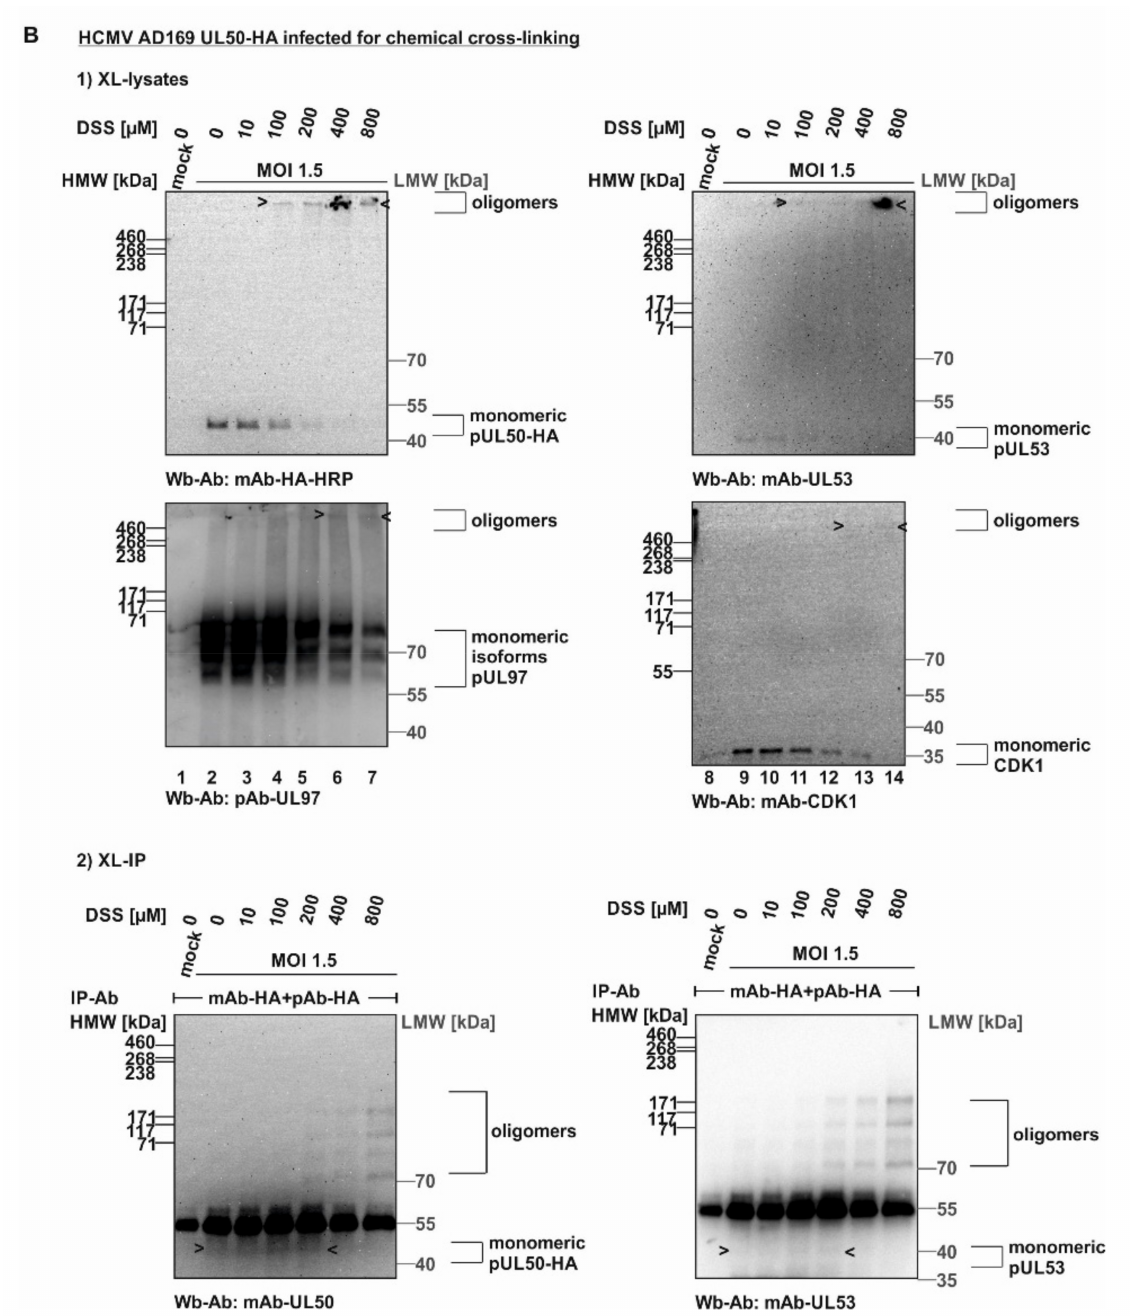
Figure 2. HCMV-infected cell proteins used to detect core NEC oligomerization and association of host cell kinases. ( A ) Human foreskin fibroblasts (HFFs) were cultivated in 6-well plates, used for HCMV AD169 infection at a multiplicity of infection (MOI) of 1.5 and harvested at 5 d p.i. Cross- linking was performed by addition of different concentrations of DSS. Core NEC oligomers and their associated protein kinases could be illustrated by Wb analysis. ( B ) HFFs were infected with HCMV AD169 UL50-HA at an MOI 1.5 and harvested at 5 d p.i. prior to performing cross-linking with DSS. Oligomeric formation and associated proteins were detected by Wb. Lower orders of core NEC oligomers were demonstrated by coimmunoprecipitation and Wb detection using the respective tag-specific antibodies. HMW/LMW, high/low molecular weight